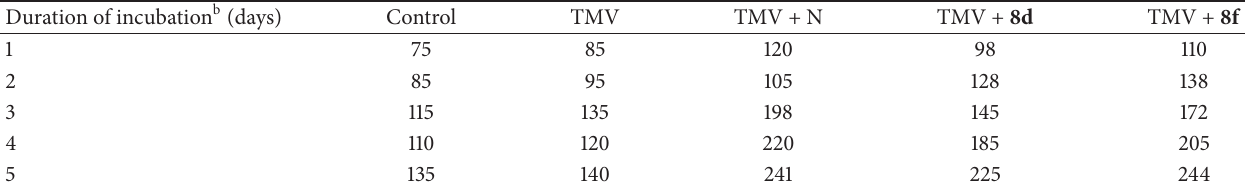
Table 3: Change in chlorophyll content (mg ⋅ g − 1 FW) in the tobacco leaves after treatment with 8d and 8f . Duration of incubation b (days)